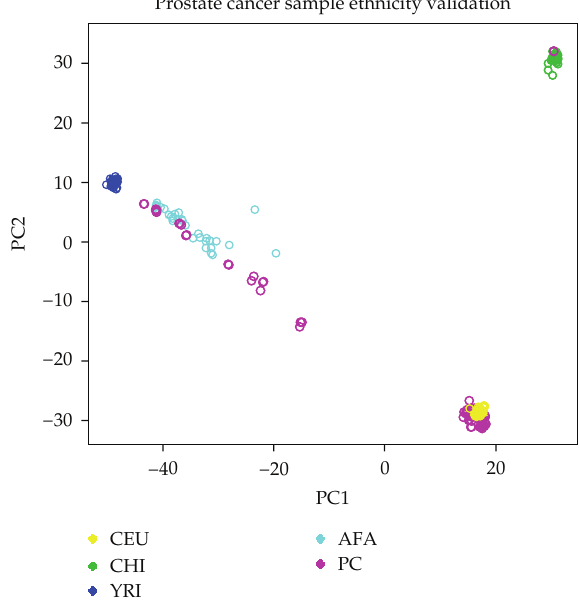
Figure 2: Principal component analysis identity testing of a variety of normal SNP profiles from the germline DNA of prostate cancer patients (cid:2) PC (cid:3) used in the study compared to a set of HapMap normal reference populations from Nigeria (cid:2) YRI (cid:3) , Europe (cid:2) CEU (cid:3) , China (cid:2) CHB (cid:3) , or, of African American (cid:2) AFA (cid:3) decent. The x and y axes represent the 1st and 2nd